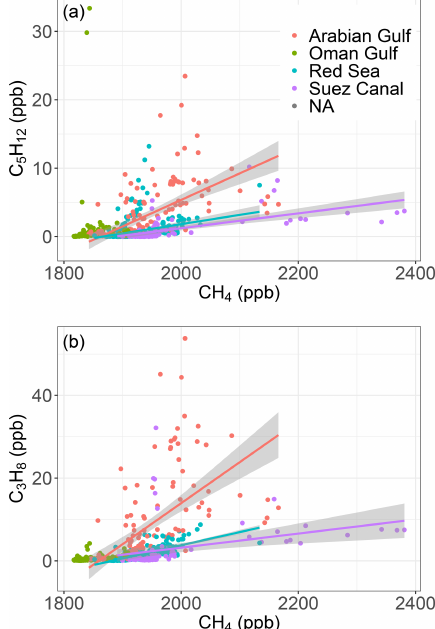
Figure 6. Scatterplot of i -pentane /n -pentane and methane (a) and i -pentane/ n -pentane and CO 2 (b) for the Oman Gulf, Arabian Gulf, Red Sea and Suez Canal. The value of the i -pentane to n -pentane ratio associated with oil and gas emission (0.86) is drawn as a hori- zontal line in the two panels.